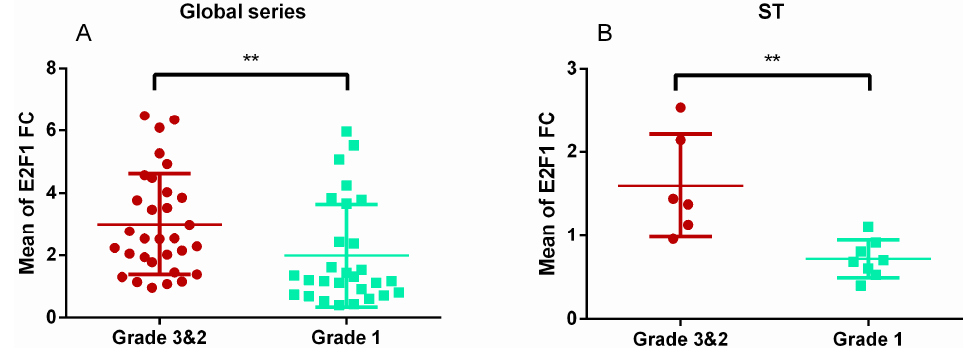
Figure 3. Different expression of E2F1 depending on invasiveness . E2F1 fold change values between invasive (grade 3 and 2) and non-invasive (grade 1) tumours in the whole sample ( A ) and in the ST subtype ( B ). ** Mann–Whitney U, p = 0.004 and p = 0.001, respectively).